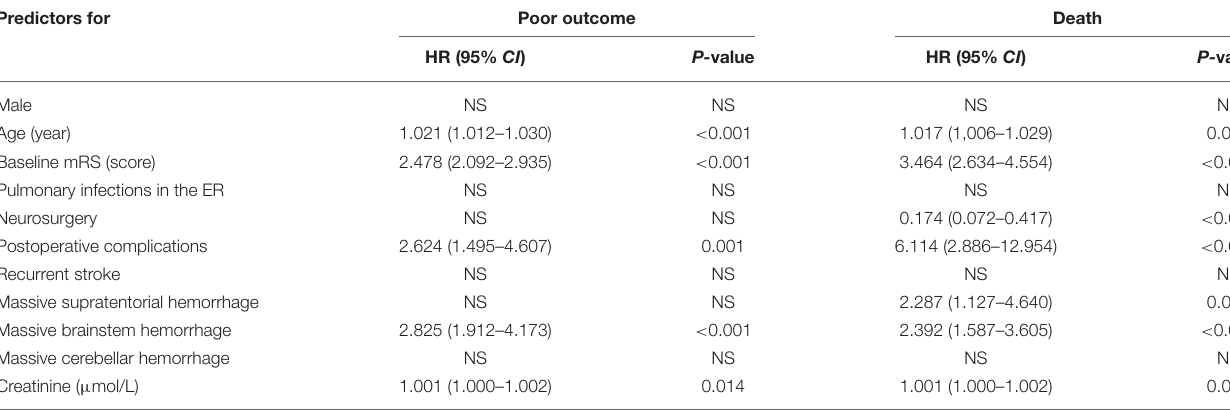
TABLE 2 | Multivariate analysis of the primary outcomes of patients in the 2020 group. Predictors